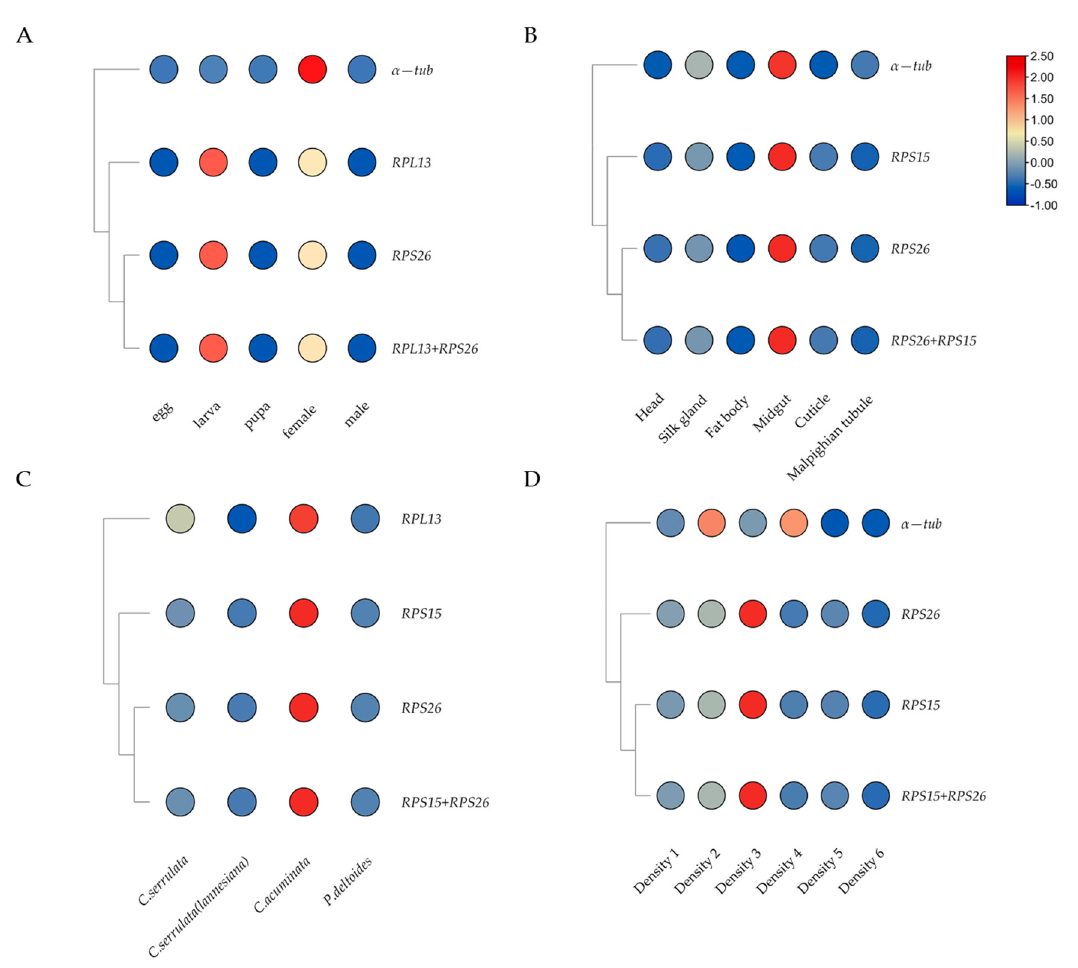
Figure 4. The expression profiles of HcSP1 under different conditions normalized by selected reference genes. ( A ) Different developmental stages. ( B ) Different tissues. ( C ) Larva feeding on different hosts. ( D ) Different larval densities.